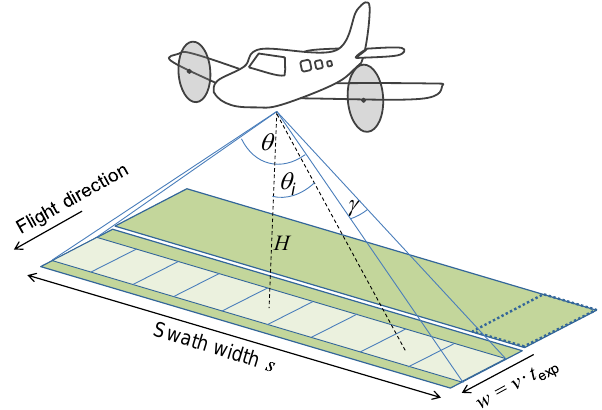
Figure 2. Sketch of the in-flight viewing geometry of the imaging DOAS instrument with flight altitude H , swath width s , single pixel length w = v · t exp , flight speed v and exposure time t exp and the instantaneous FOV along track (defined by opening angle γ ) and across track (opening angle θ ). The FOV across track is divided into individual viewing directions θ i